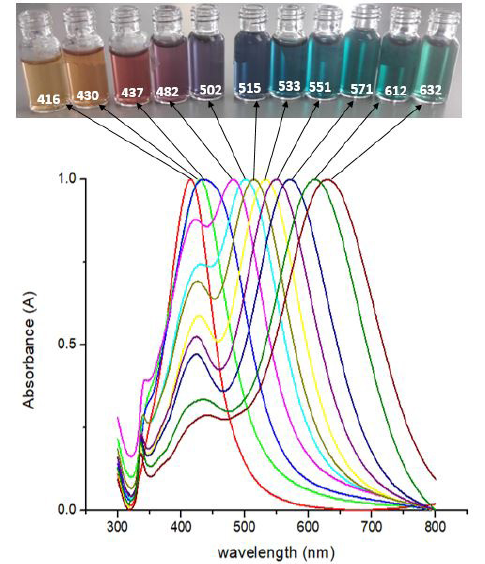
Figure 1. Shift plasmon absorption bands for colloidal dispersions of AgNPs. From left to right: AgNP-00 (416 nm), AgNP-10 (430 nm), AgNP-20 (437 nm), AgNP-30 (482 nm), AgNP-35 (502 nm), AgNP-40 (515 nm), AgNP-45 (533 nm), AgNP-50 (551 nm), AgNP-55 (571 nm), AgNP-60 (612 nm), AgNP-65 (632